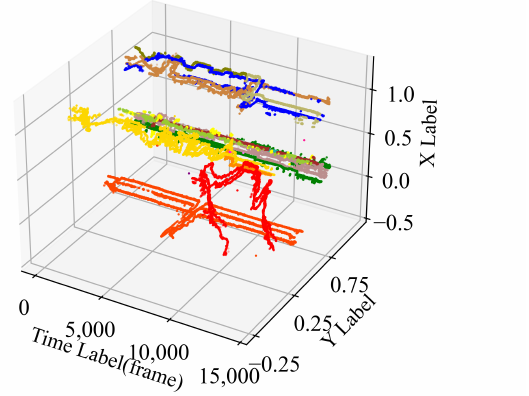
Figure 4. The 3D trajectories of different cameras. The colors differ among